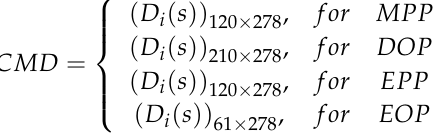
Figure 7. Trend of weights along with the time lag.